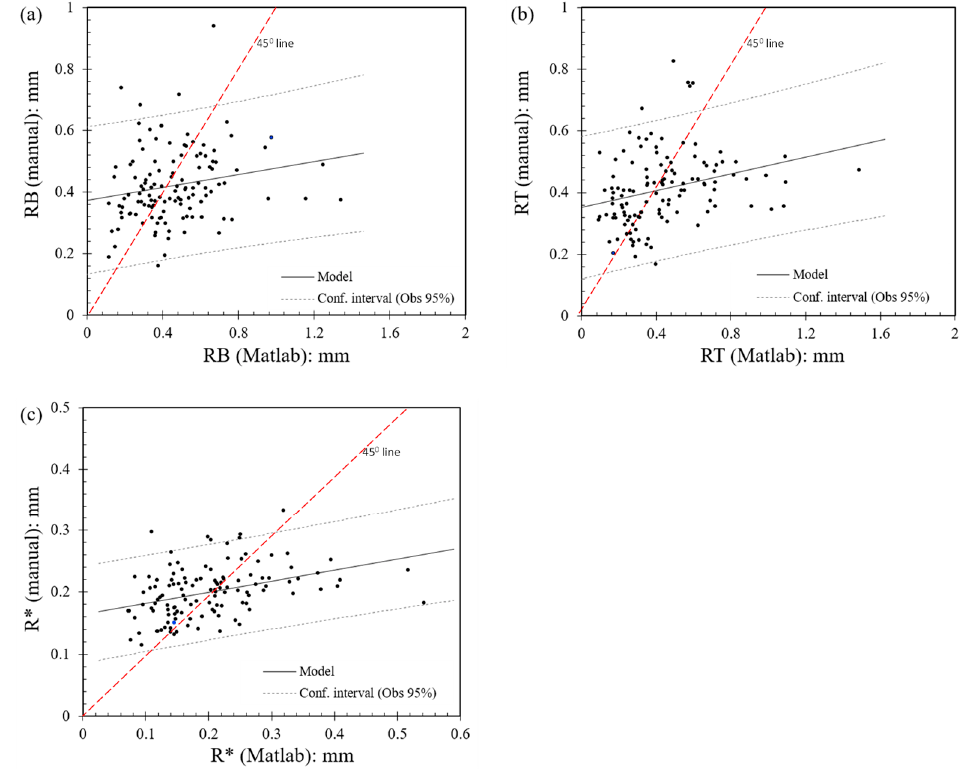
Figure 4. Comparison of ( a , b ) local radii of bottom and top grains and ( c ) equivalent radii based on Matlab and manual analysis of local morphology of the grains (experiments at 0.01 mm/min speed). Table 2. Summary of test results in terms of local radius and equivalent radius computation based on Matlab and manual analysis of local